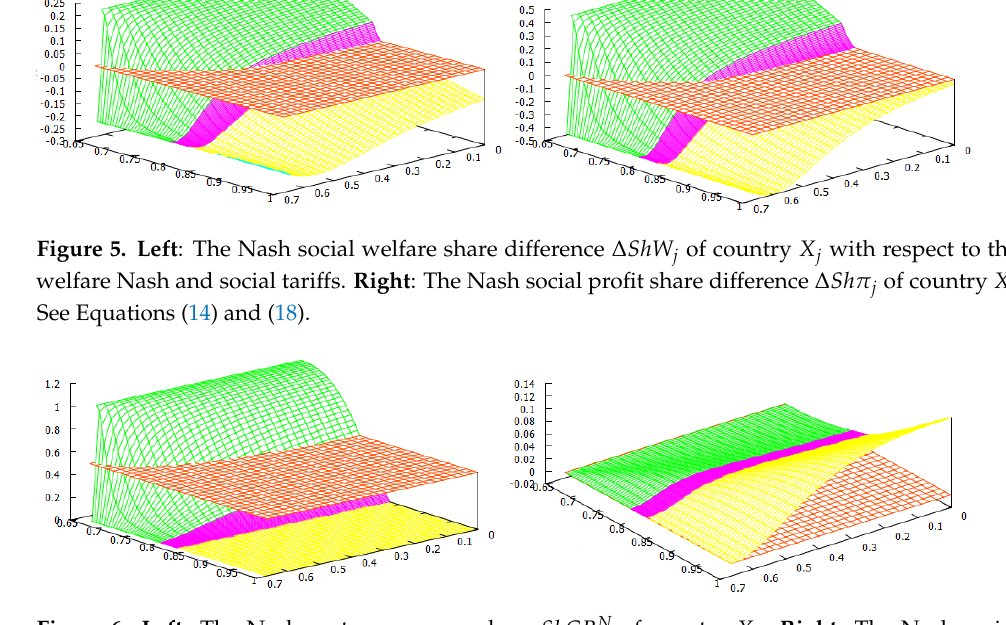
of country X j . Right : The Nash social j